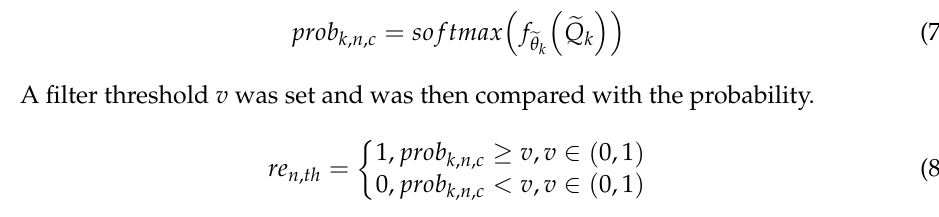
Figure 3. Relationship between the clean sets and the raw sets. The noise filtering model was obtained based on the noisy training set and test set.